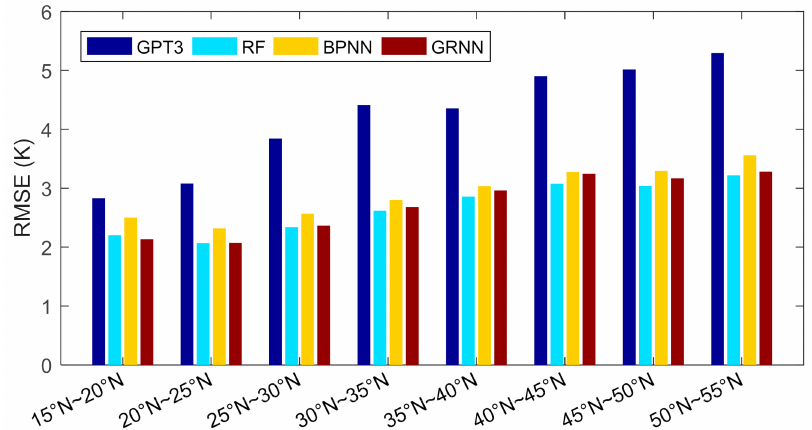
Figure 8. Root mean square errors of different models at different latitude